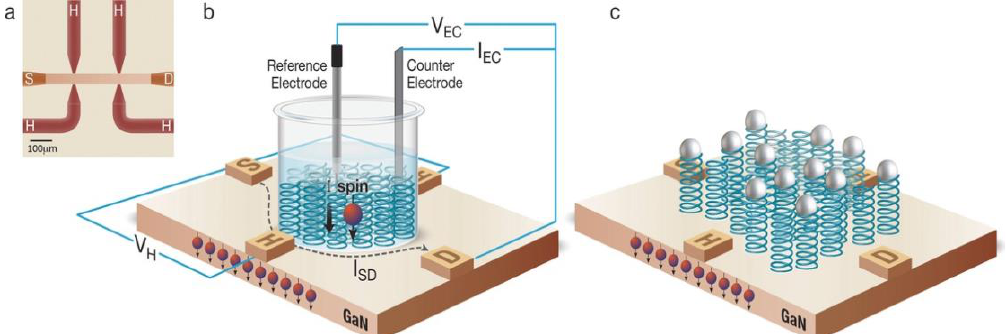
Figure 5. Schematic representation of the experimental setup. (a) Optical image of the GaN-based Hall device. S and D are the source and drain electrodes, respectively, and H marks the tip electrode contacts used for the Hall potential measurement. (b) View of the combined electrochemical/Hall device apparatus. (c) Working electrode covered with Ag nanoparticles, the redox probe, attached to the adsorbed oligopeptide monolayer (Reproduced with permission from [28], WILEY-VCH, 2017).